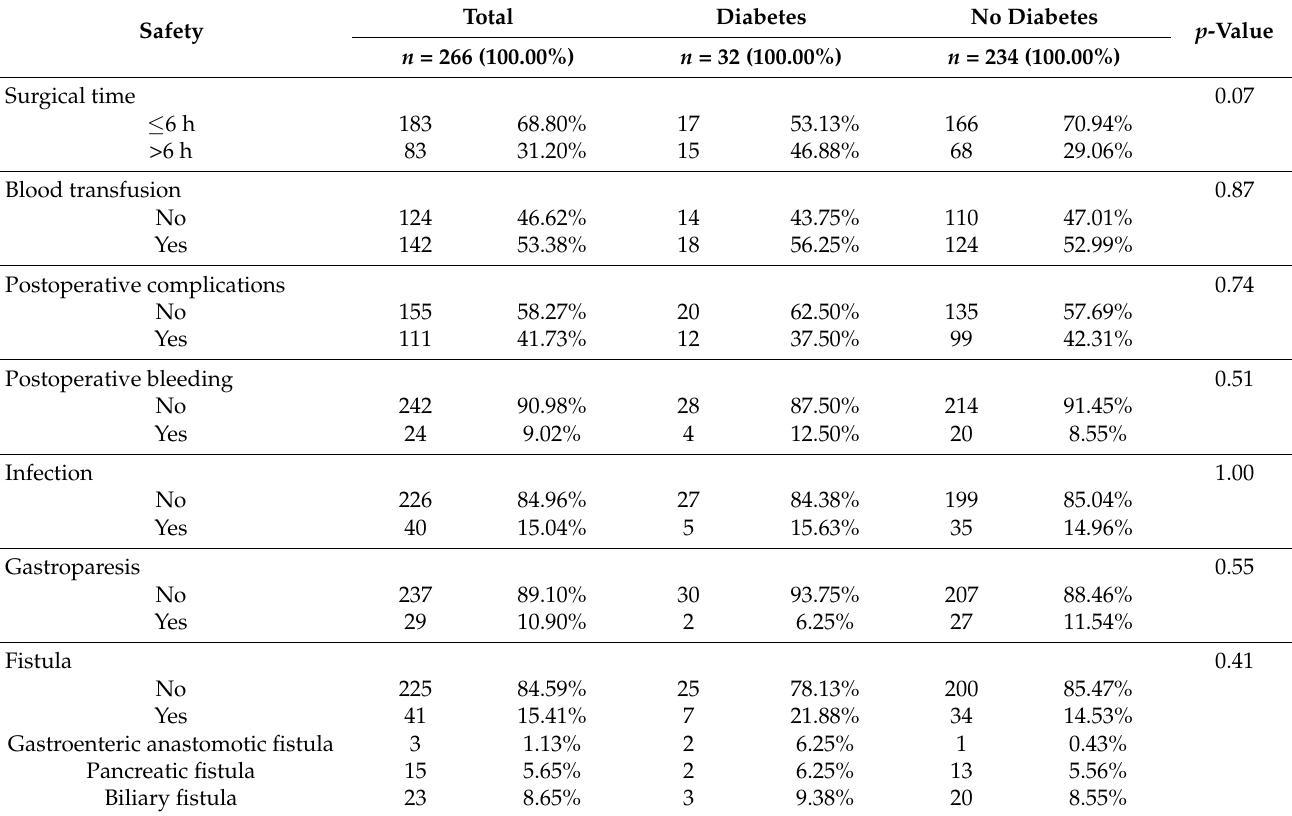
Table 2. Short-term outcomes of ampullary adenocarcinoma patients between the diabetes group and the no diabetes